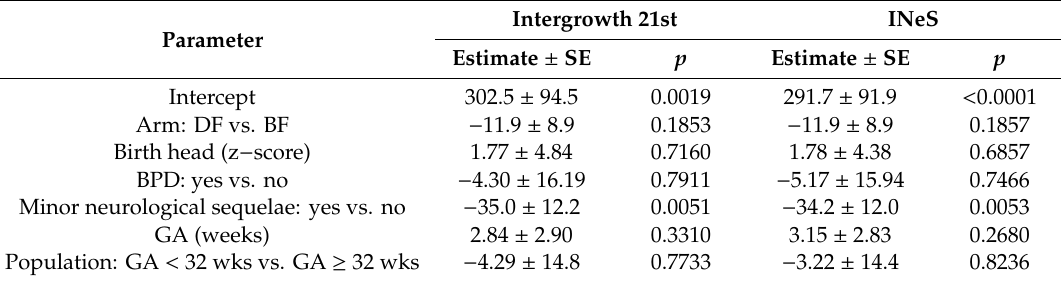
Table 2. Estimate of linear regression coefficients.